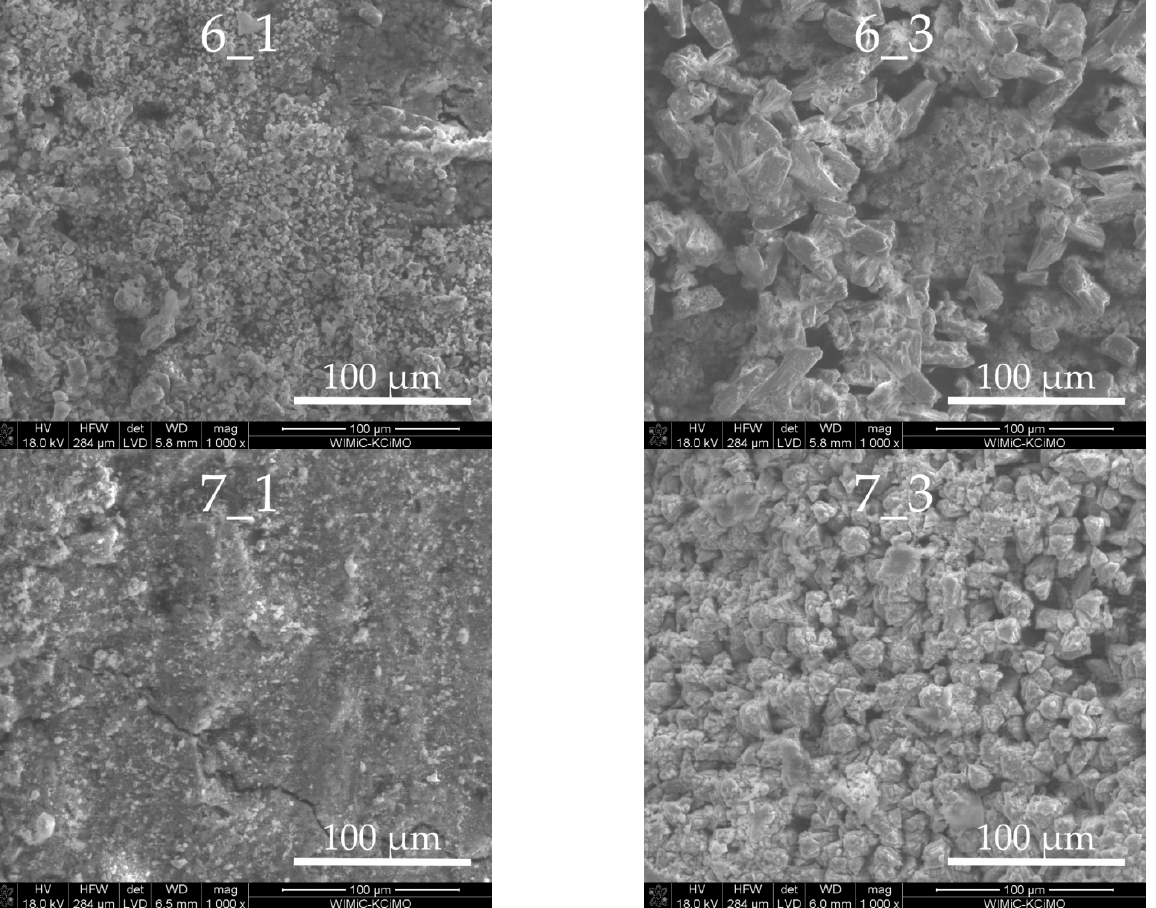
Figure 2. SEM micrographs of the cement pastes obtained after exposure under the conditions of: ( a ) water (samples 1_1–7_1) and ( b ) pig slurry (samples 1_3–7_3).